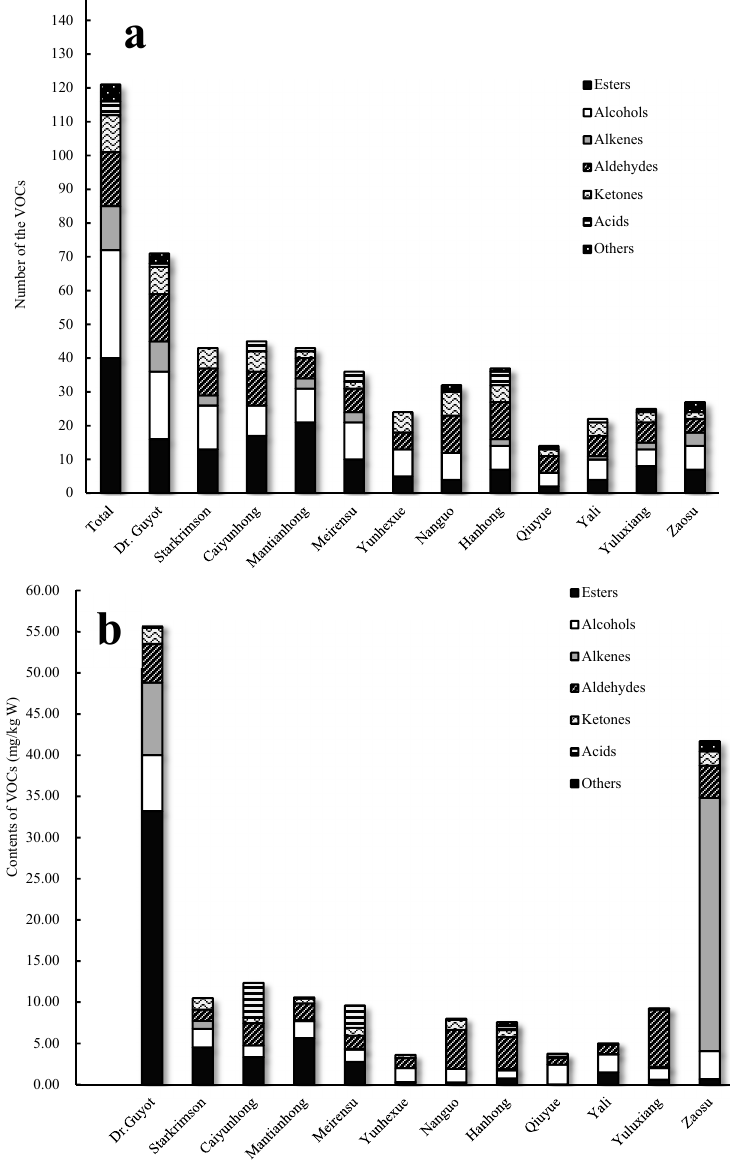
Figure 1. The number ( a ) and contents ( b ) of VOCs detected in 12 cultivars of pear fruits. Note: n = 3, equivalent of cyclohexanone.